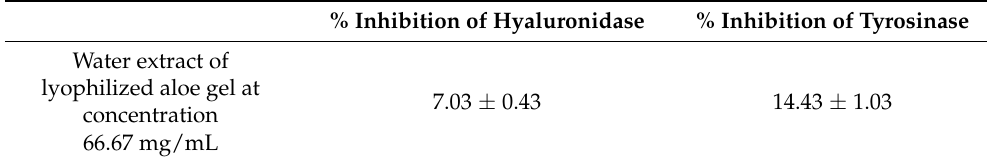
Table 3. Inhibition of hyaluronidase and tyrosinase